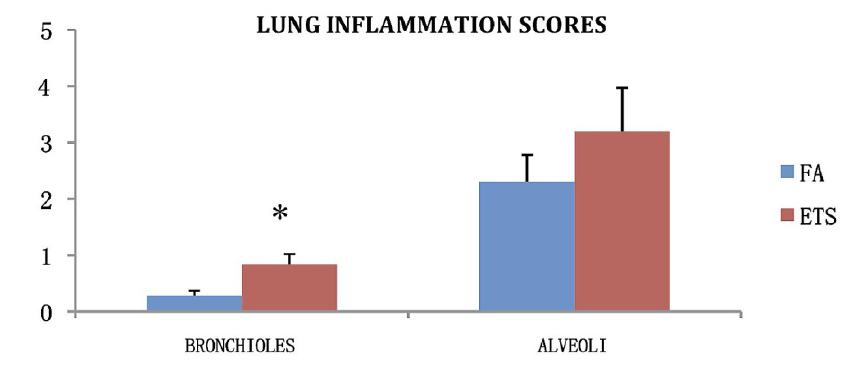
Figure 7. Average inflammation scores for each lung lobe of virus only infected animals. Scores are calculated as extent times severity of inflammation, for both the alveoli and the bronchiolar sub mucosa. Data is presented as the group mean (n = 10) ± SEM. * indicates a significant difference between the FA and ETS groups in that